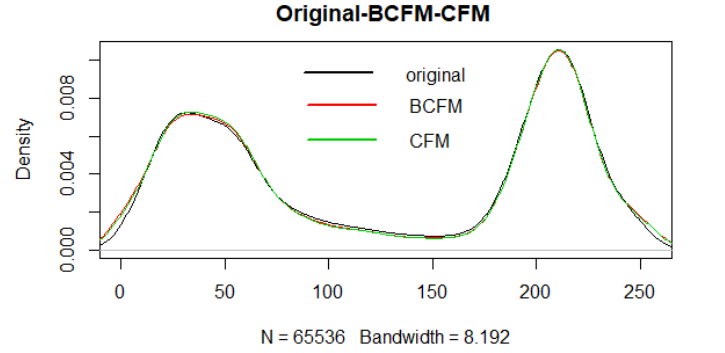
Figure 12. Density graph of the original, CFM, and BCFM images.